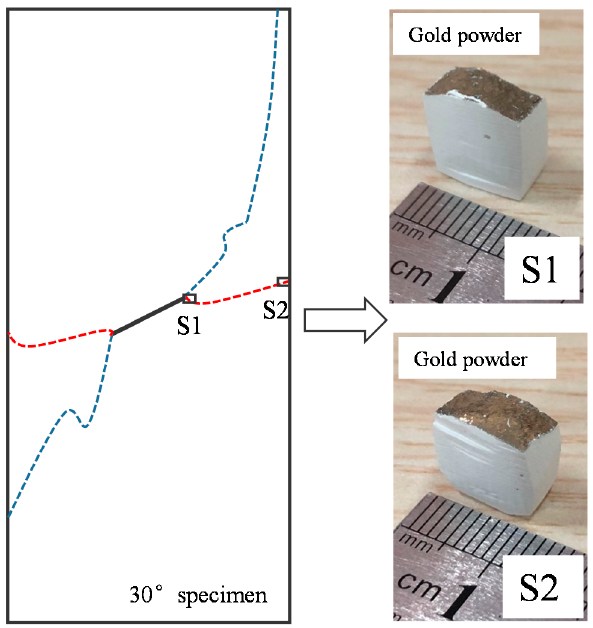
Figure 6. SEM scanning specimens of HCC in a 30° specimen.